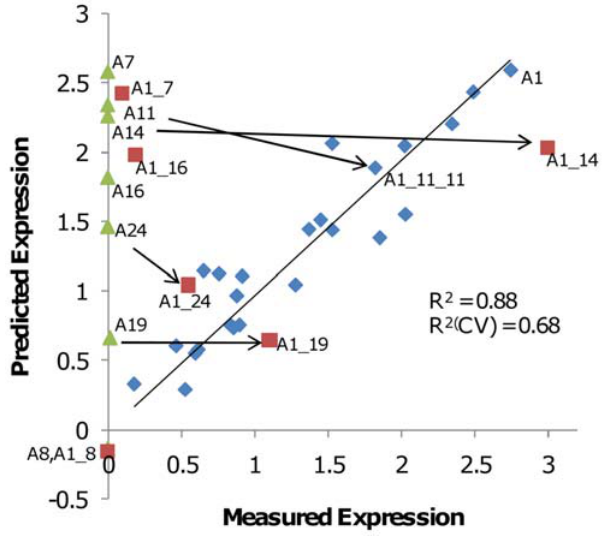
Figure 4. Modification of 5 9 sequence improves the perfor- mance of some scFv variants. For each scFv variant the measured expression level was plotted against the expression predicted from a PLS model using genetic algorithm-selected codons. Blue diamonds indicate the 24 gene training set used to create the model, Green triangles are variants from the initial set with undetectable expression. Red squares are new variants created by combining the first segment (the first 15 codons) of variant A1 with the remainder of these 6 poorly- expressed variants. Arrows indicate changes in predicted and measured expression upon 5 9 codon exchange. Variants represented as green triangles or red squares were not included in the training set from which the model was built. Variant A1_11_11, in which a larger 43 codon portion of the 5 9 section of the A11 gene was replaced with that of A1, is also indicated for comparison.